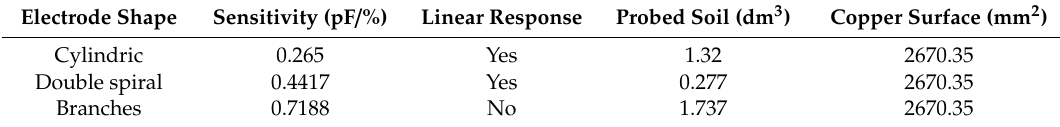
Table 2. Summary of the three sensor’s characteristics.